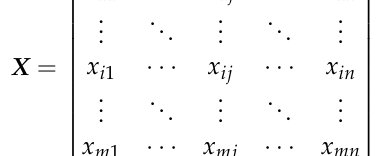
Figure 4. Flowchart of the fuzzy comprehensive evaluation method.